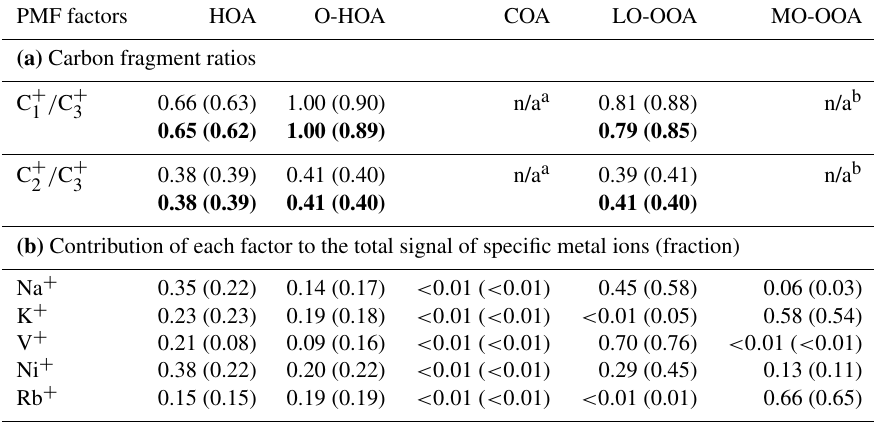
Table 1. (a) Carbon fragment ratios observed by the laser-on measurement for each PMF factor. The bold text represents the results with both rBC fragments and trace metal ions included as PMF input. (b) The contribution of each PMF factor to the total signal of specific metal ions. For the entire table, the values in parenthesis are those obtained from PMF with the CDCE-corrected input matrix (see details in the Supplement – S1 and Table